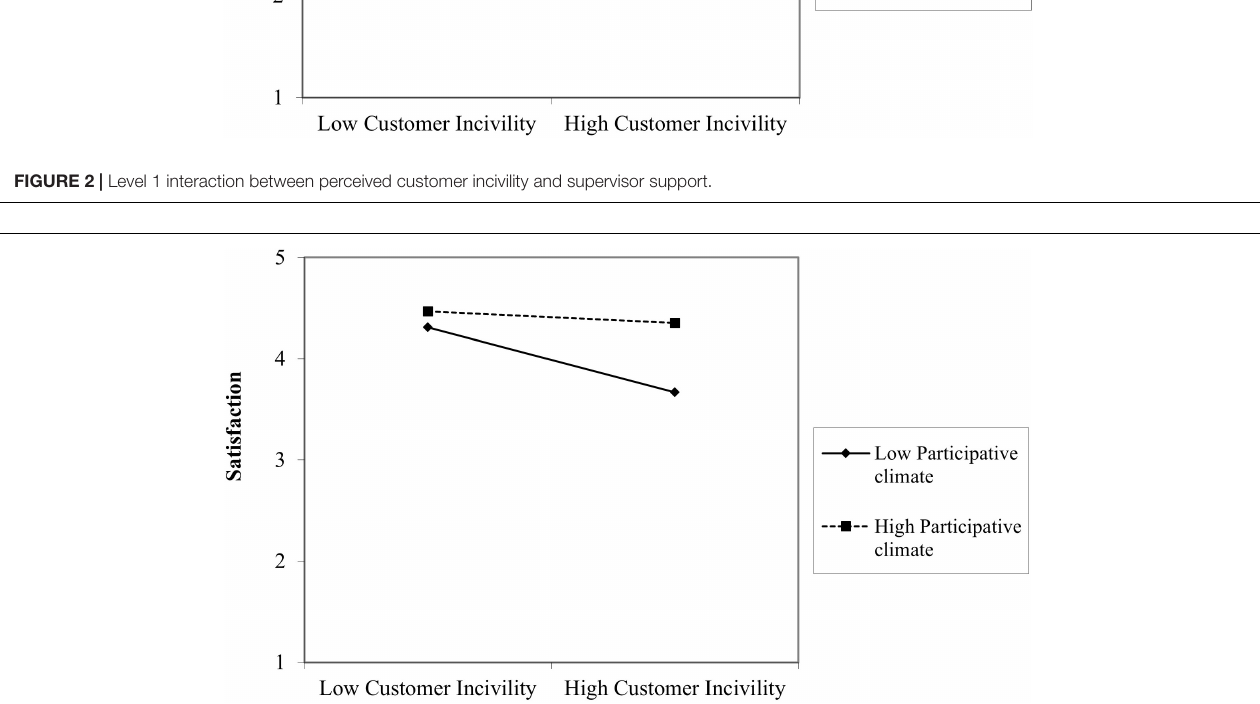
FIGURE 3 | Cross-level moderating effects of participative